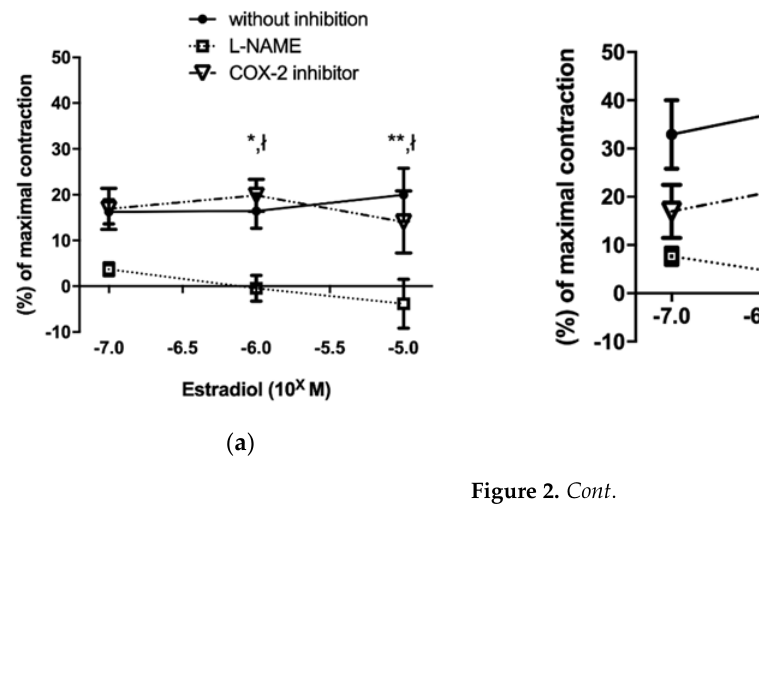
Figure 1. Estradiol dependent vasorelaxation. All precontracted thoracic aorta segments dilated as a result of increasing concentrations of estradiol. In the vitamin D deficient groups, significantly reduced estradiol-induced vasorelaxation was measured, which seemed to be independent of the androgen status. Data are presented as mean ± SEM. *: p < 0.05 T-D+ vs. T-D-, #: p < 0.05 T-D+ vs. T+D-, łł: p < 0.01 T+D+ vs. T-D-, ˆ: p < 0.05 T+D+ vs. T+D-, ˆˆ: p < 0.01 T+D+ vs. T+D-.